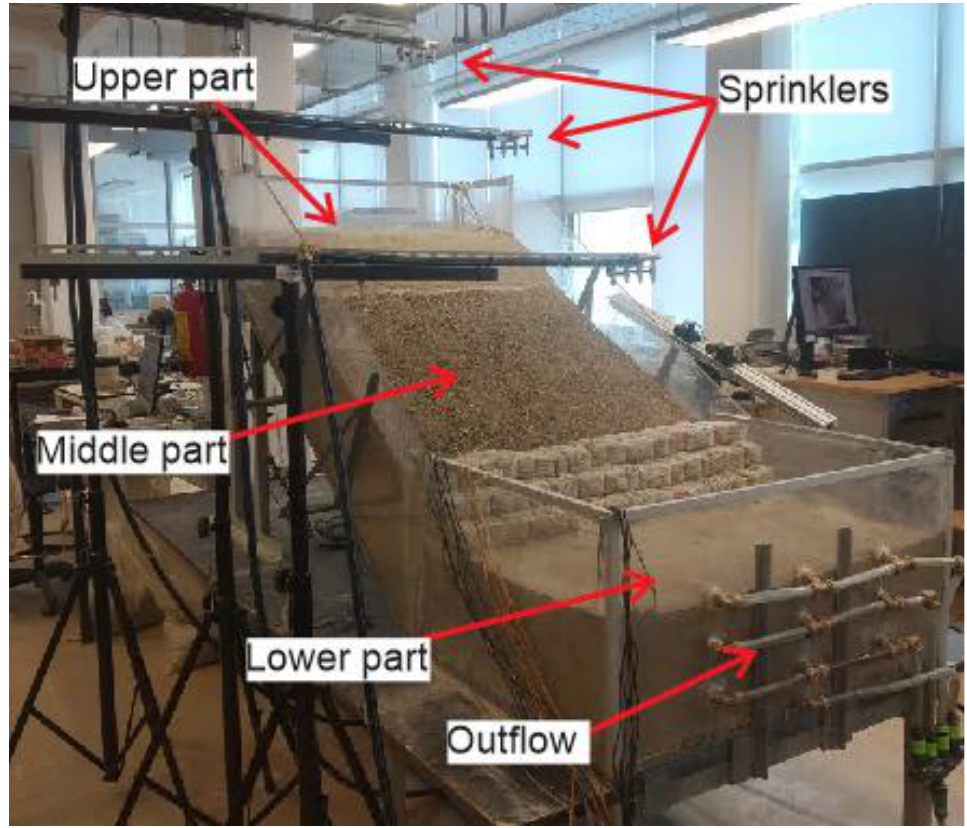
Figure 1. A photo of the small-scale landslide model with a gabion wall applied as a remediation measure at the slope toe and with the indication of the main model elements.